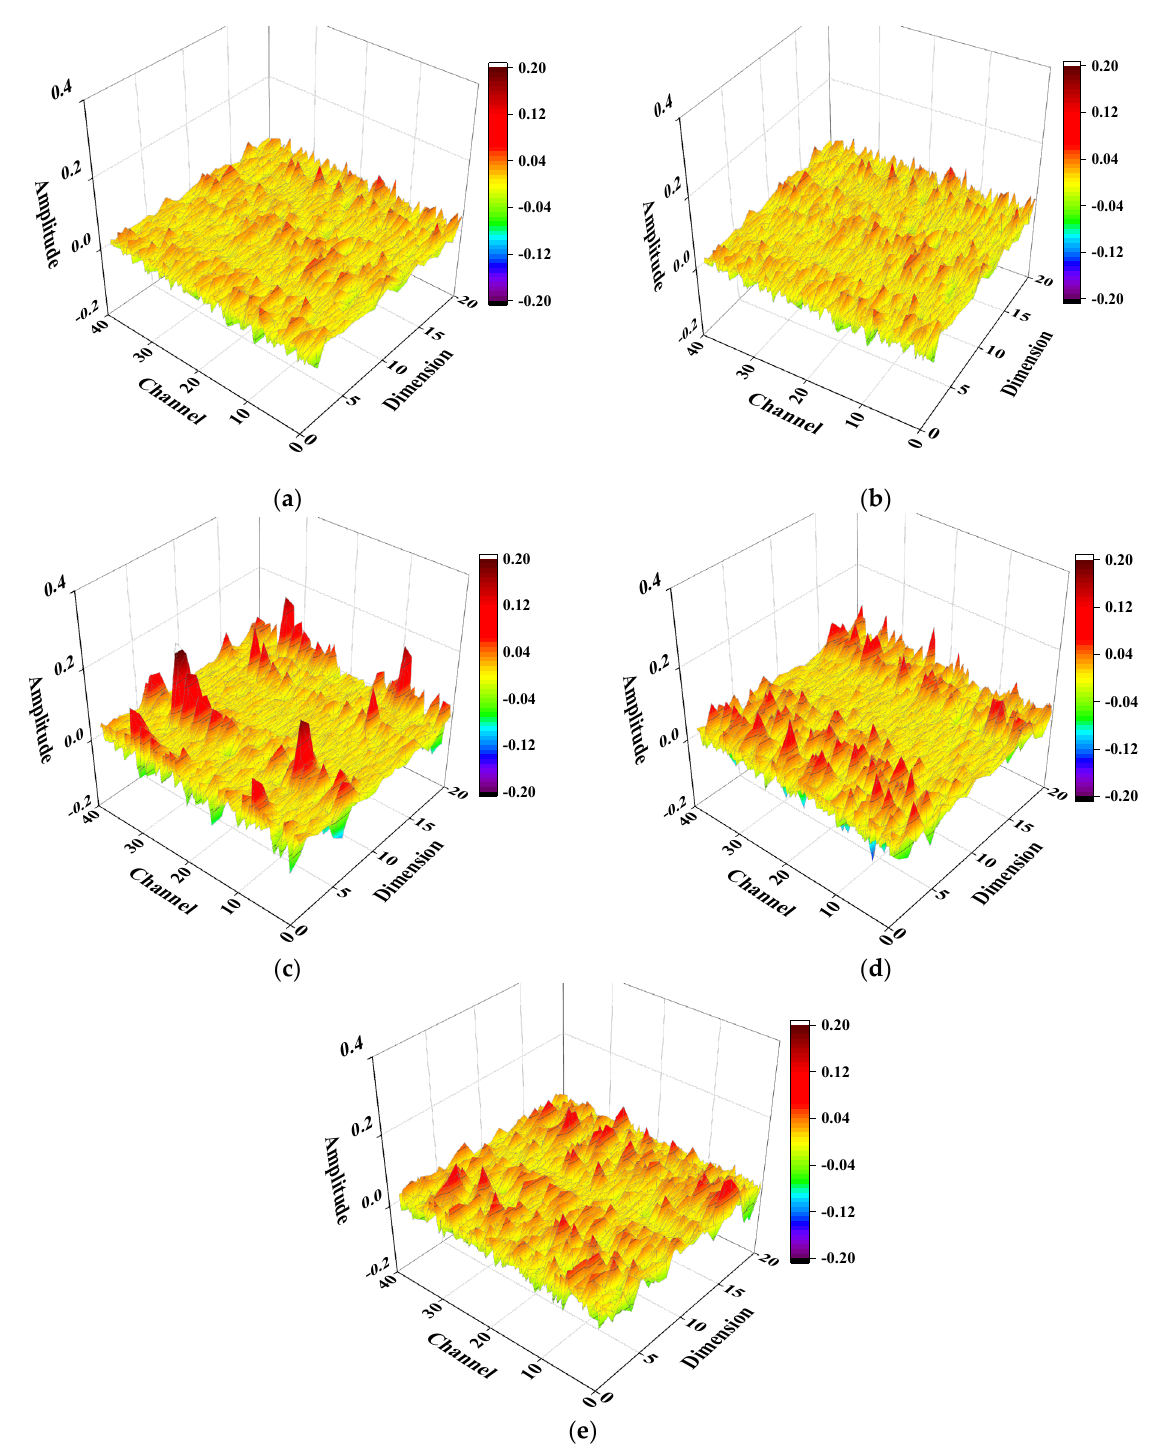
Figure 16. Weights of the third convolutional layer at 60 dB: ( a ) Group 1; ( b ) Group 2; ( c ) Group 3; ( d ) Group 4; ( e ) Group 5.